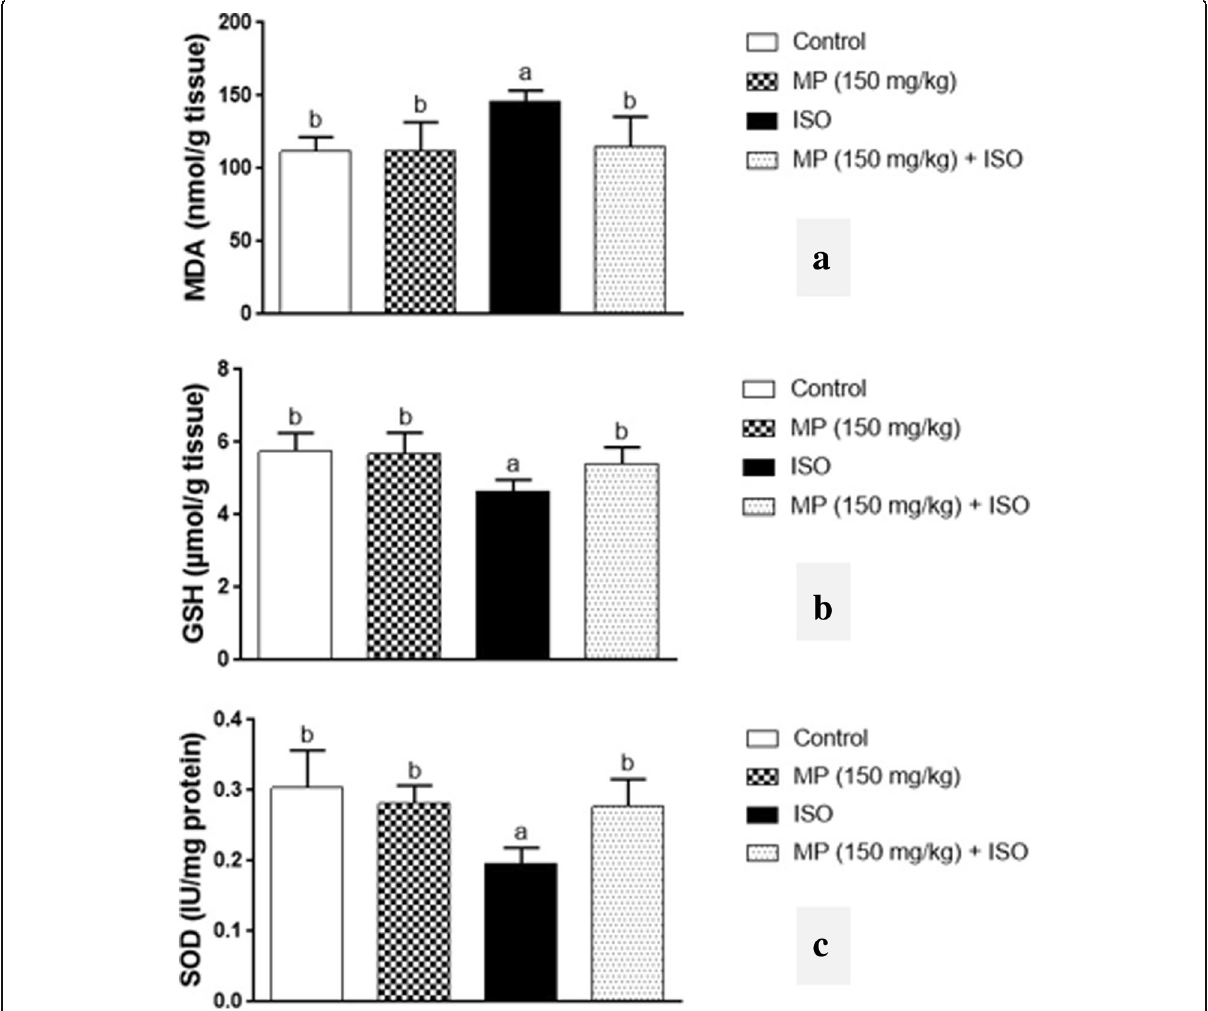
Fig. 4 Effect of MP (150 mg/kg) on cardiac content of MDA and GSH and cardiac activity of SOD in ISO-intoxicated rats. a MDA. b GSH. c SOD. Rats were pretreated with MP (150 mg/kg, p.o) three times per week on alternating days for 2 weeks and then injected with 2 consecutive doses of ISO (85 mg/kg, s.c) on the 13th and 14th days; data are presented as mean ± SD ( n = 7); a or b: significantly different from control or ISO groups respectively at P < 0.05 using one-way ANOVA followed by Tukey as a post hoc test. MP methyl palmitate, ISO isoproterenol, MDA malondialdehyde, GSH reduced glutathione, SOD superoxide